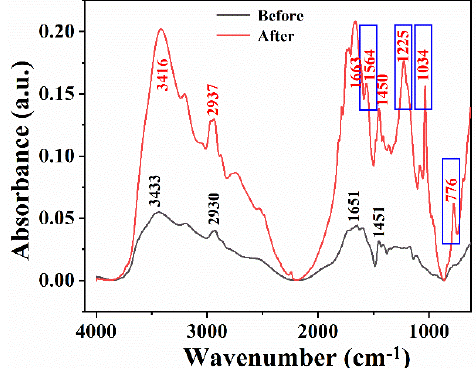
Figure 2. FTIR spectra of the P(AAm − AAc − TBAm) hydrogel before and after modification of lysozyme-binding aptamer. The appearance of new absorption peaks at 1564 cm − 1 , 1225 cm − 1 , 1034 cm − 1 and 776 cm − 1 demonstrated the successful modification of the aptamers.